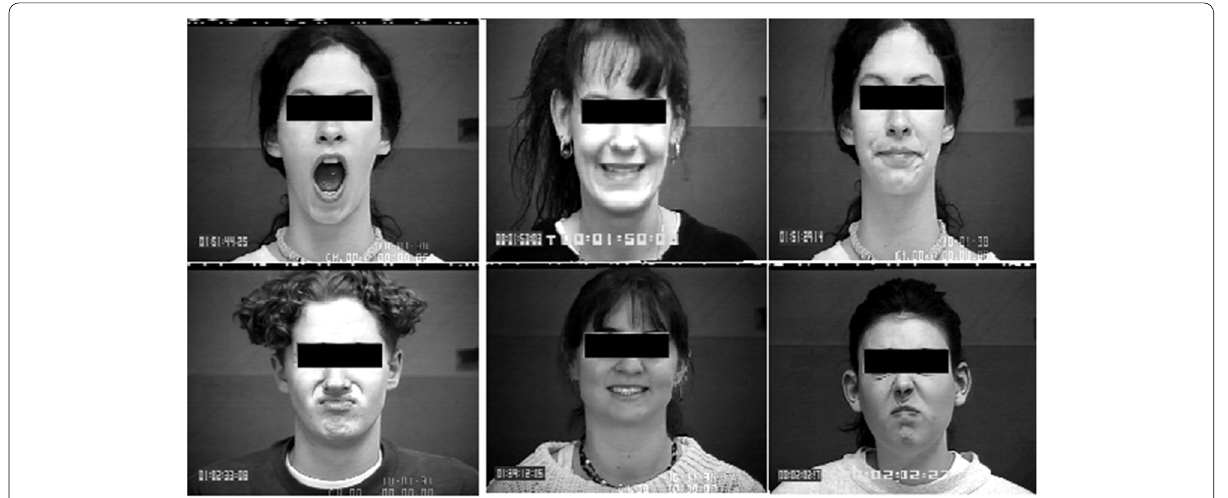
Fig. 9 Sample images in CK